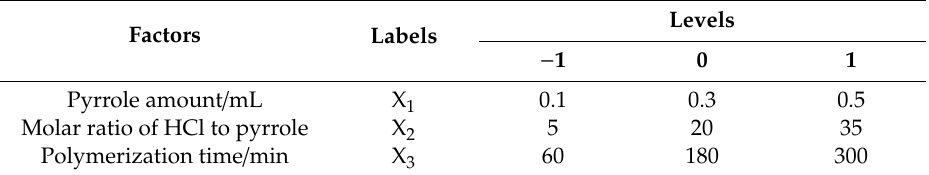
Table 1. Experimental range and levels of independent